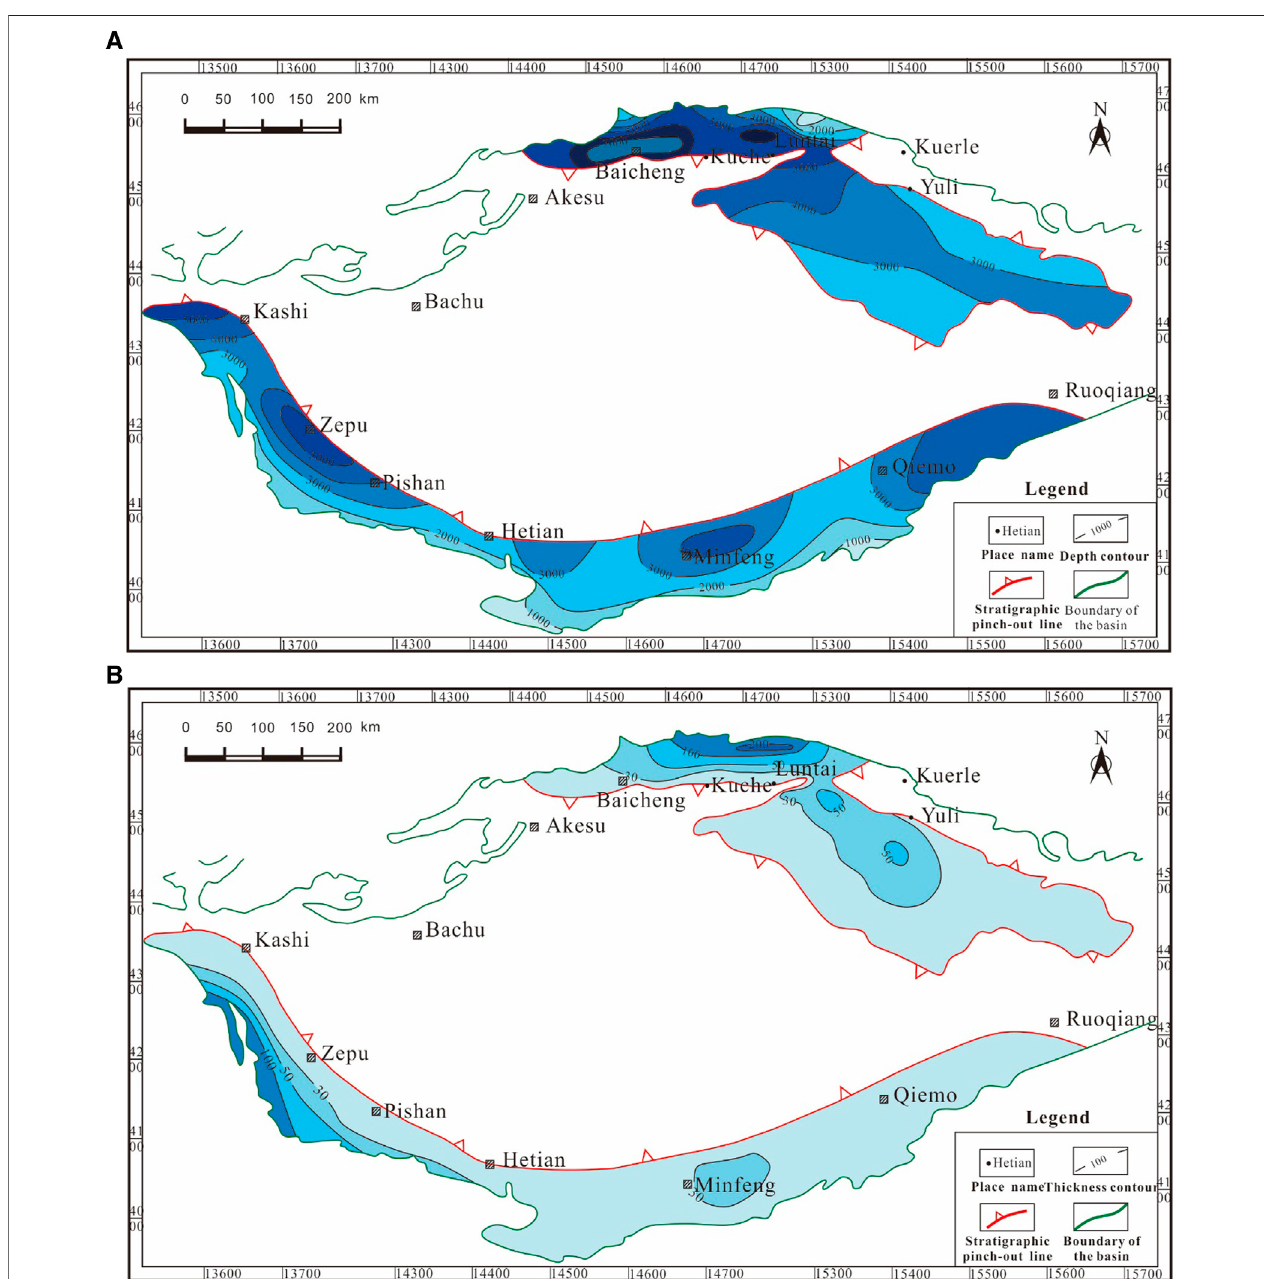
FIGURE2|(A) ContourmapofburieddepthofLowerJurassicshaleintheTarimBasin. (B) ContourmapofeffectiveshalethicknessofLowerJurassicintheTarim Basin.